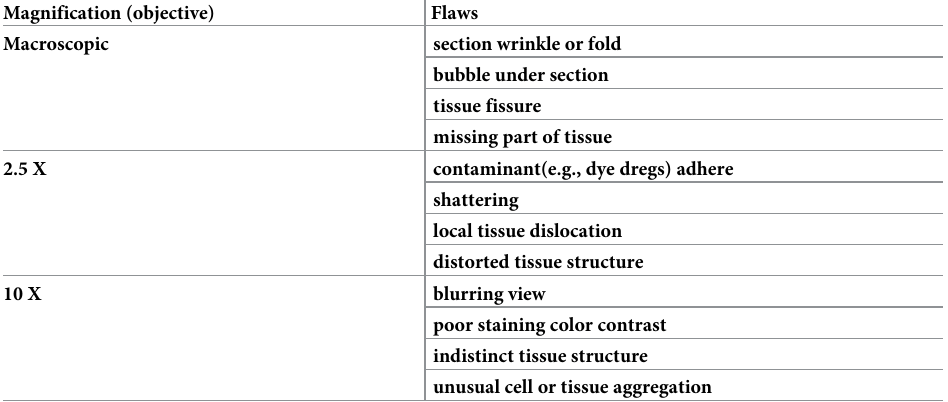
Table 1. Artifacts observed on a staining